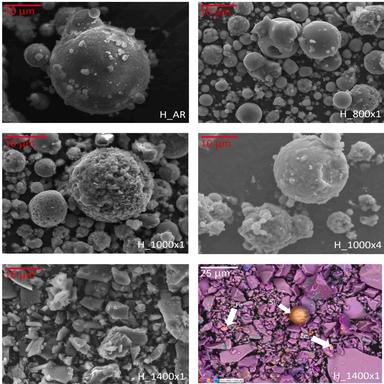
Secondary electron images of Fly Ash H AR (A); cycled to 800◦Cx1 (B); cycled to 1000◦Cx1 (C); cycled to 1000◦Cx4 (D); cycled to 1400◦Cx1 (E), and a BSE image with elemental mapping after cycling to 1400◦Cx1. All images are at 2300x magnification, except E which is magnified 950x and C, which is 3000x.